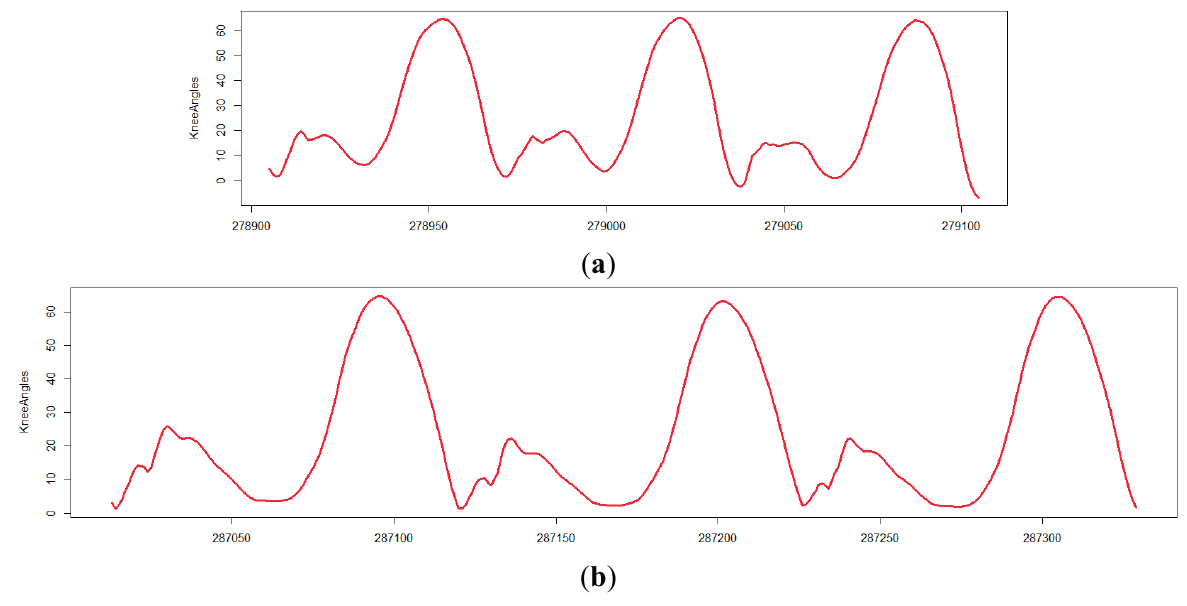
Figure 2. The knee angle curves of Patient 3 during the task of walking on a level surface. The arthritic instability of the knee exhibited by Patient 3 before surgery ( a ; standing leg remains almost stiff) was barely visible after surgery ( b ; normal heel-toe stride in stance